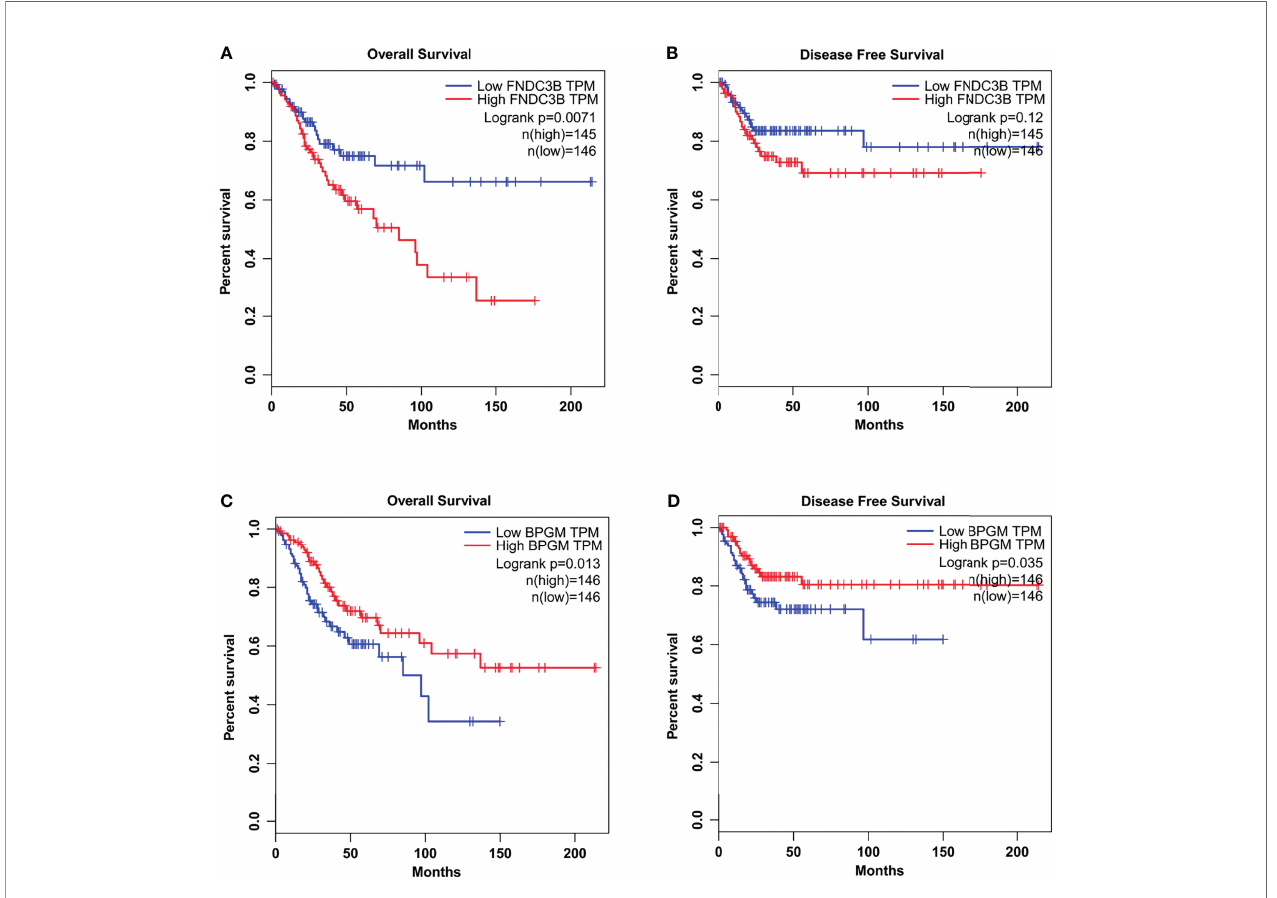
FIGURE 7 | The relationships between FNDC3B (or BPGM) expression and the clinical outcome in CCa patients. (A) A higher expression of FNDC3B exhibited a signi fi cantly worse OS. (B) A higher expression of FNDC3B exhibited a worse DFS. (C, D) A lower expression of BPGM exhibited a signi fi cantly worse OS and